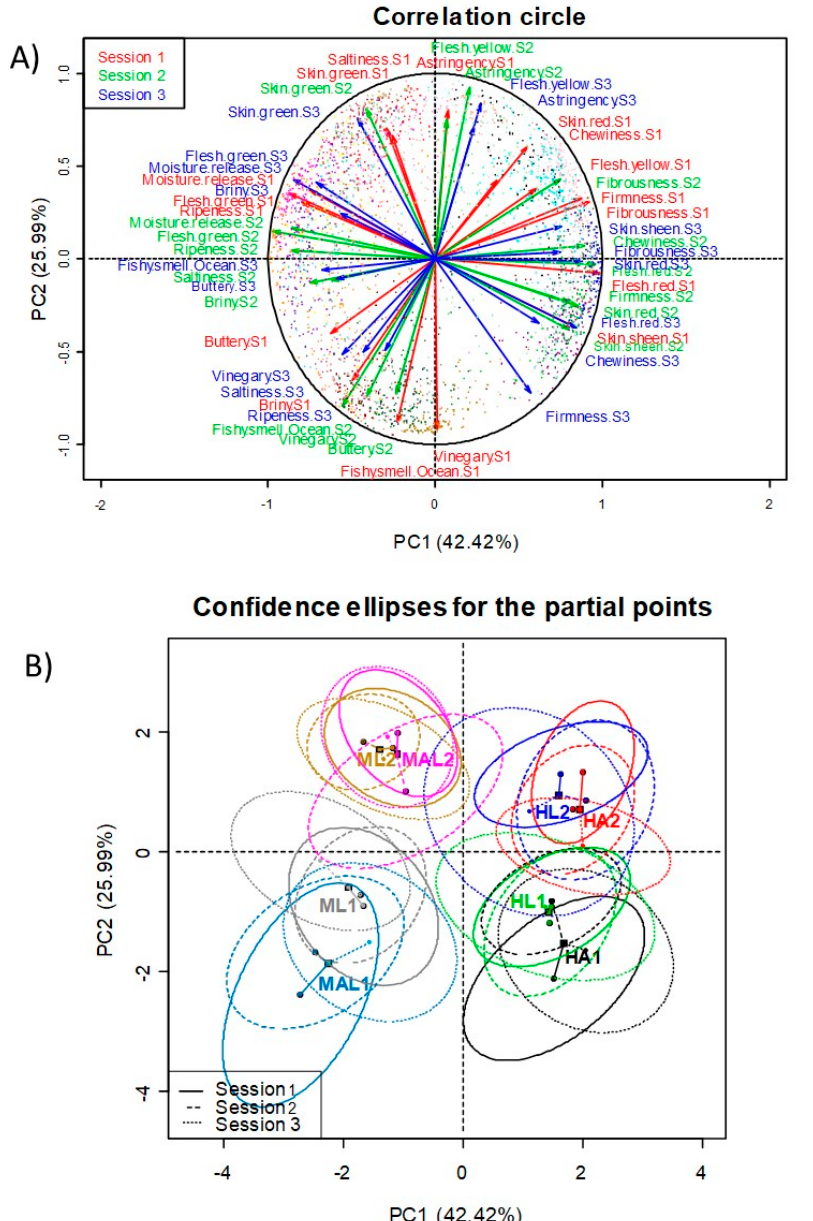
Figure 8. Panel repeatability as assessed by multivariate analysis, using bootstrapping. ( A ) Projection of the descriptors ‘loads on the correlation circle onto the first two Principal Components, and ( B ) Projection of the samples’ scores and confidence ellipses according to sessions onto the first two Principal Components.